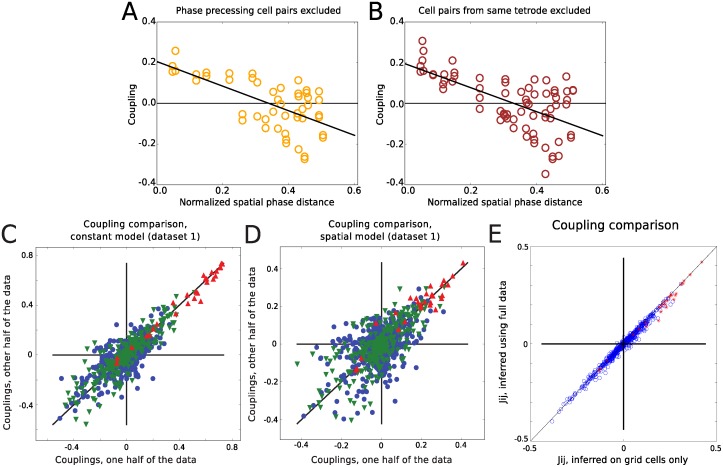
Stability of the inferred couplings.Stability of the phase-dependent trend in inferred couplings filtered for cell pairs where at least one cell is phase precessing (A), as well as for couplings filtered for cells on the same tetrode (B). The phase dependence of the coupling can be seen to be similar to when all pairs were included. Couplings inferred using one random half of the data plotted against those inferred from the other half, assuming constant external field (C) or Gaussian spatial fields (D). The within module couplings (green triangles) consistently show more stability across partitions of the data than the between module couplings (blue circles), but not as much as the self-couplings (red triangles). A: PCC, within modules = 0.88, PCC, between modules = 0.73, PCC, SC = 0.99. B: PCC, within modules = 0.73, PPC, between modules = 0.51, PCC, SC = 0.94. (E) The effect on between grid cells-couplings from including non-grid cells in the inference for the biggest data set (data set 1, 65 cells) is small.